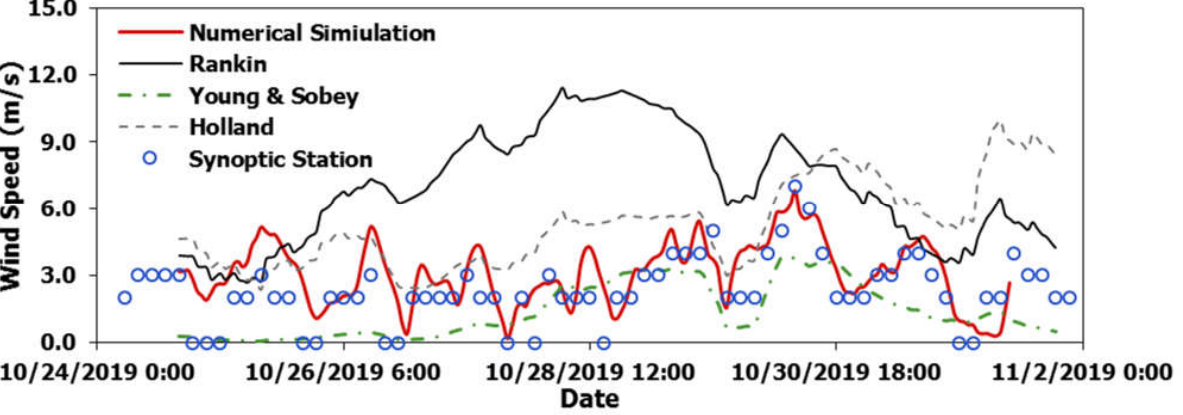
Figure 6. Comparison of the wind speed from simulations and meteorological synoptic data during tropical cyclone Kyarr at the Chabahar station.